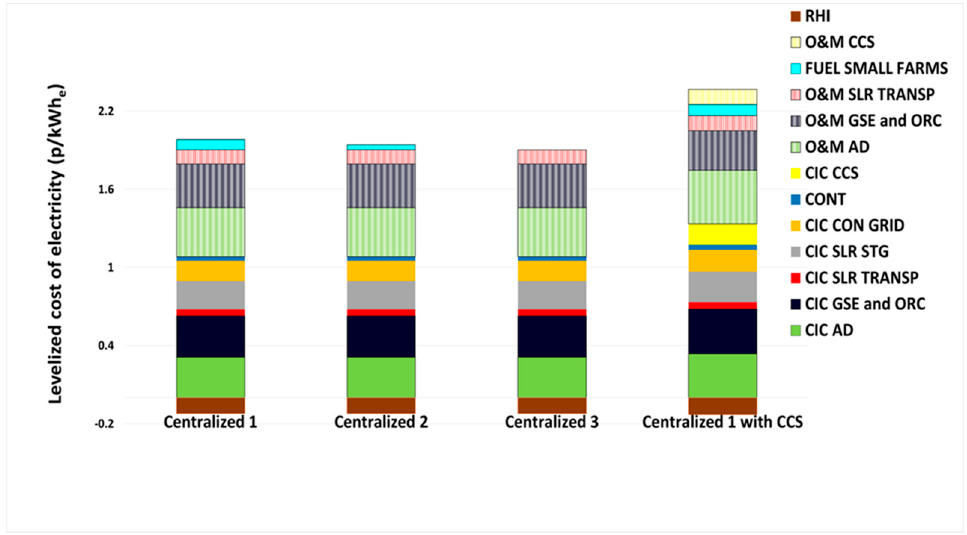
Figure 5. Levelized cost of electricity for the different centralized schemes.